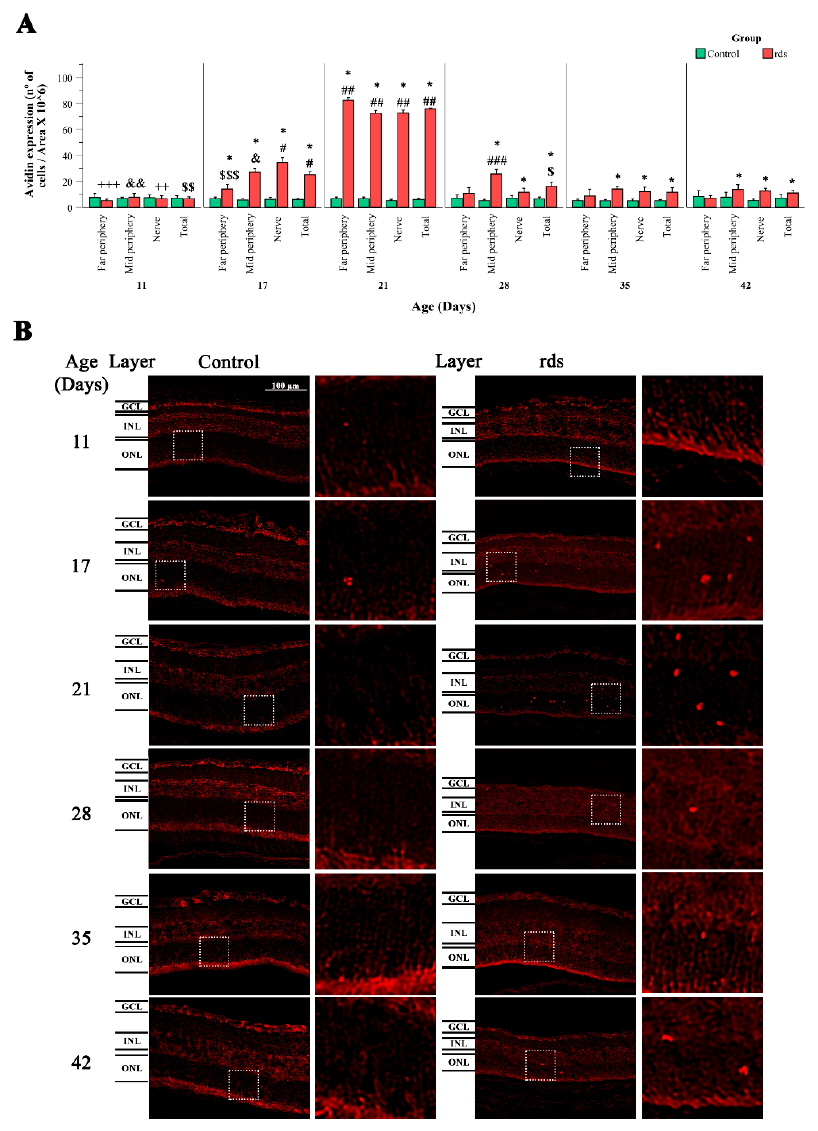
Figure 5. Nuclear oxidative damage in the retina of control and rds retinas. ( A ) Number of retinal avidin-positive cells divided by area per 10 6 in retinal areas (far periphery, midperiphery, and near